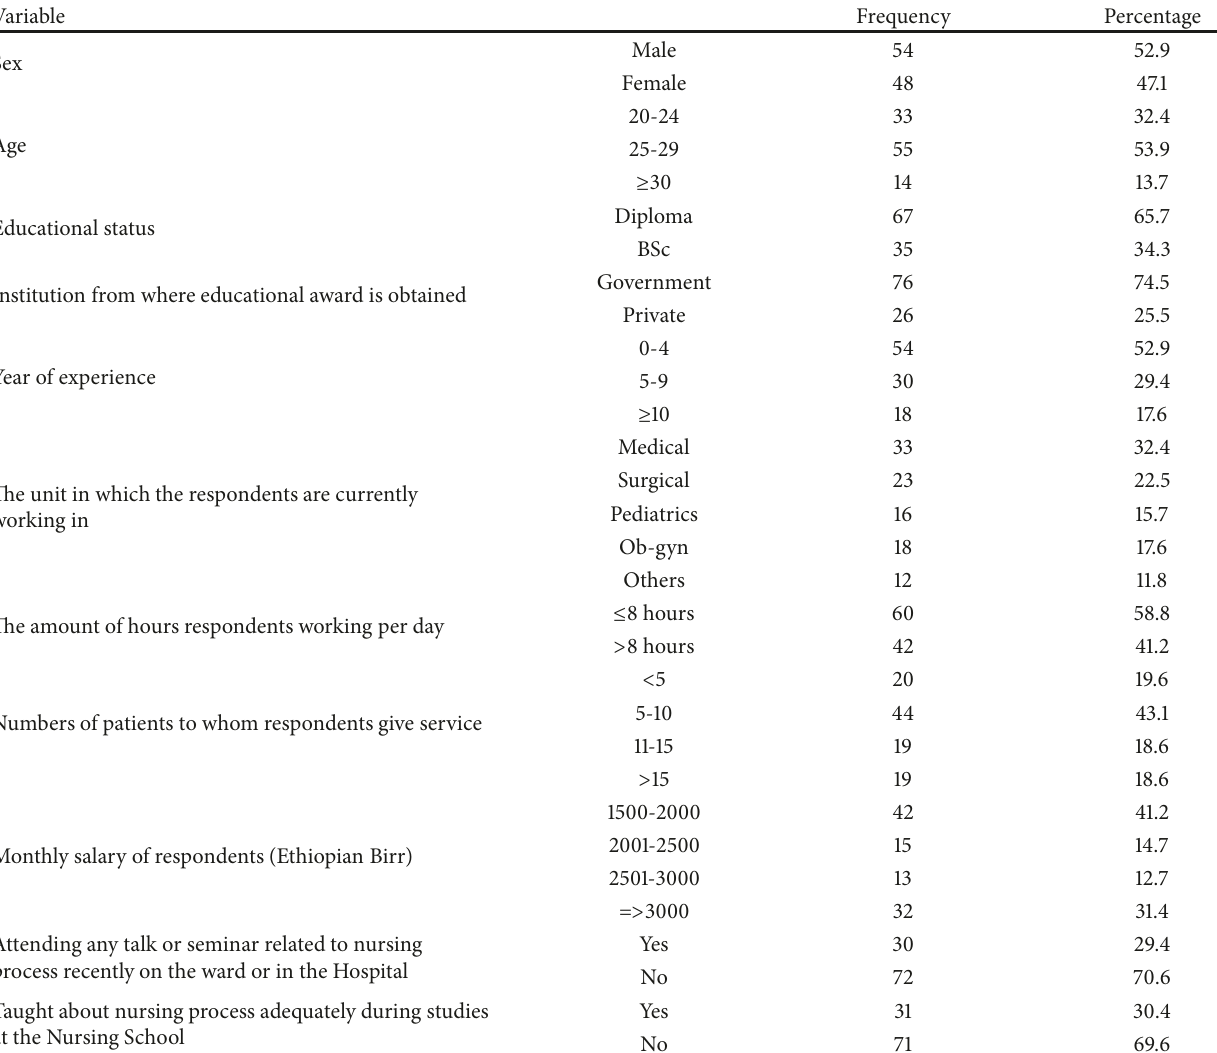
Table 1: The frequency distribution of the Respondents by their sociodemographic characteristics in Afar region hospitals, Afar, north East Ethiopia, 2016 (n=